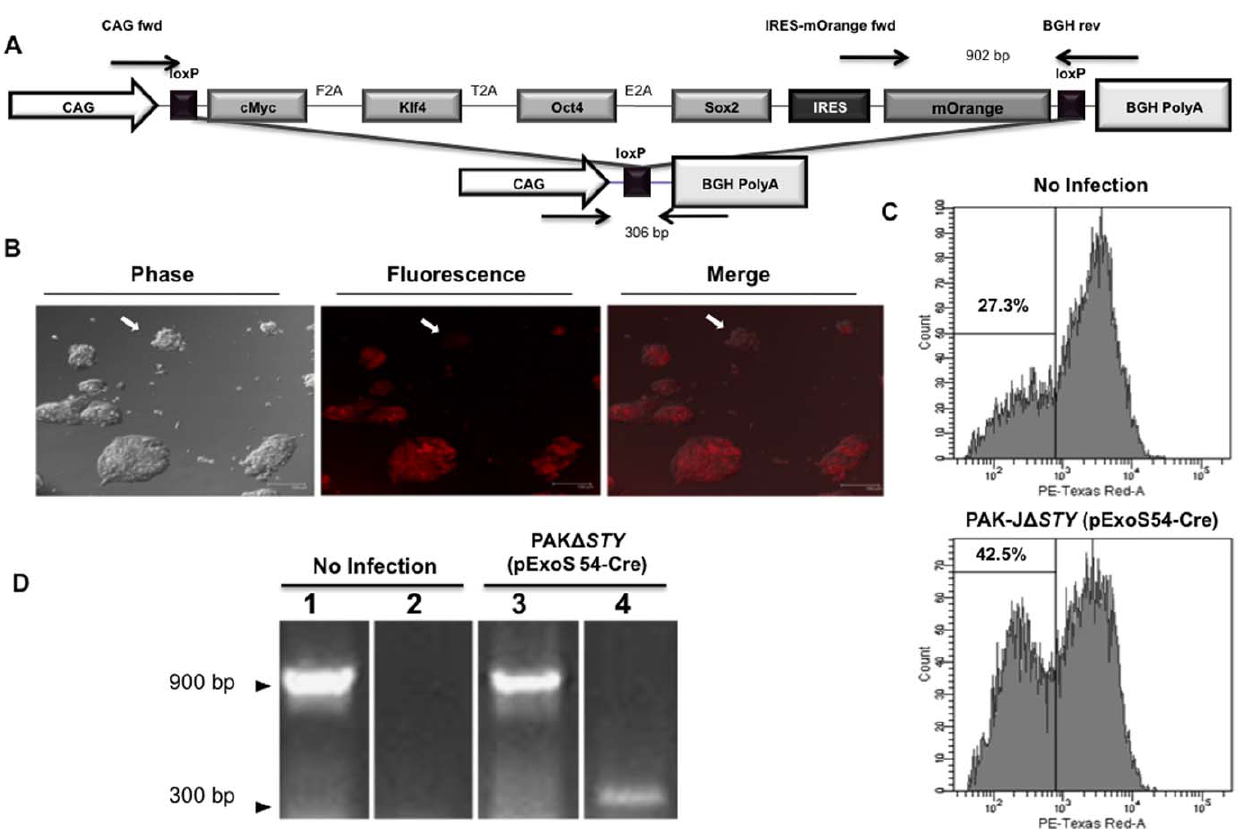
Figure 5. ExoS54-Cre mediated excision of an iPSC nuclear reprogramming cassette. TNGim05 iPSC contain a floxed reprogramming cassette ( A ). ExoS54-Cre mediated recombination results in loss of mOrange expression, which can be observed by fluorescence confocal microscopy ( B ) and flow cytometry ( C ). Reprogramming cassette excision is confirmed by PCR analysis ( D ). Lanes 1 and 3, IRES primer set, lanes 2 and 4, CAG primer set.